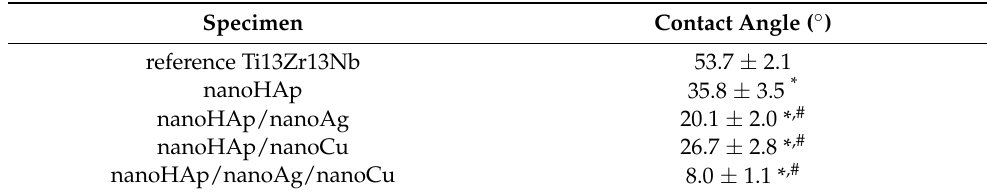
Table 5. Water contact angle at room temperature for the tested reference Ti13Zr13Nb alloy and nanoHAp-based coatings (* significantly different results compared to the reference Ti13Zr13Nb alloy, and # significantly different results compared to the nanoHAp coating, according to a one-way ANOVA test followed by Tukey’s multiple comparison test, p <